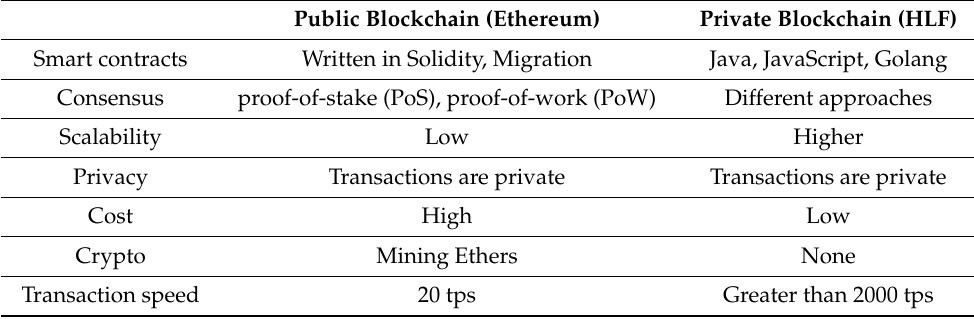
Table 1. The summary of the comparison of public and private blockchain